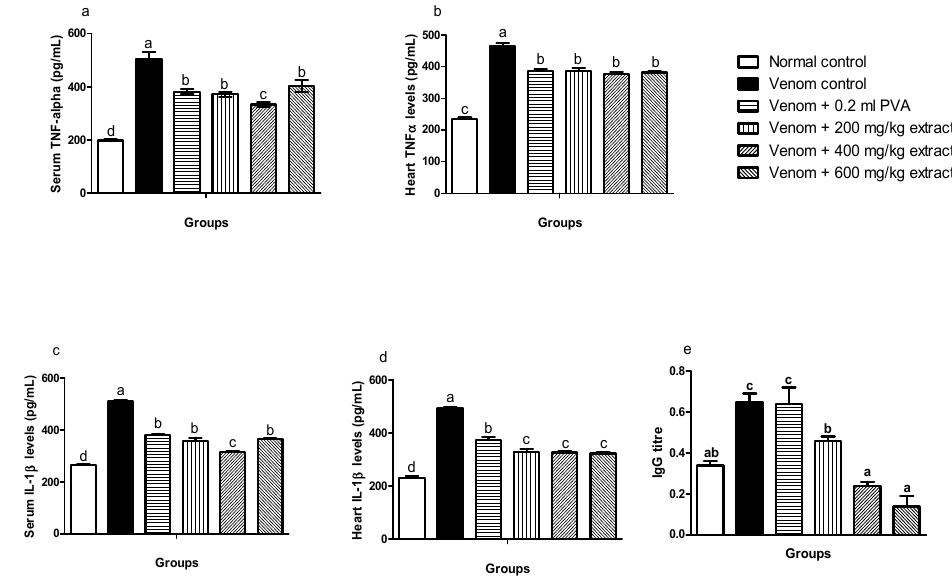
Figure 4. Effects of M. oleifera extract on TNF: α , IL: 1 β in serum and heart tissues, and immunoglobulin G levels in challenged with E. ocellatus venom. Data are expressed as mean ± SD ( n = 3). Bars with different letters are statistically distinct ( p < 0.05). ( a ) serum TNF: α ; ( b ) heart TNF: α ; ( c ) serum IL: 1 β ; ( d ) heart IL: 1 β ; ( e ) serum IgG. PVA: polyvalent antivenom; TNF: α -Tumour necrosis factor-alpha; IL: 1 β -interleukin-1 beta; IgG: immunoglobulin G.